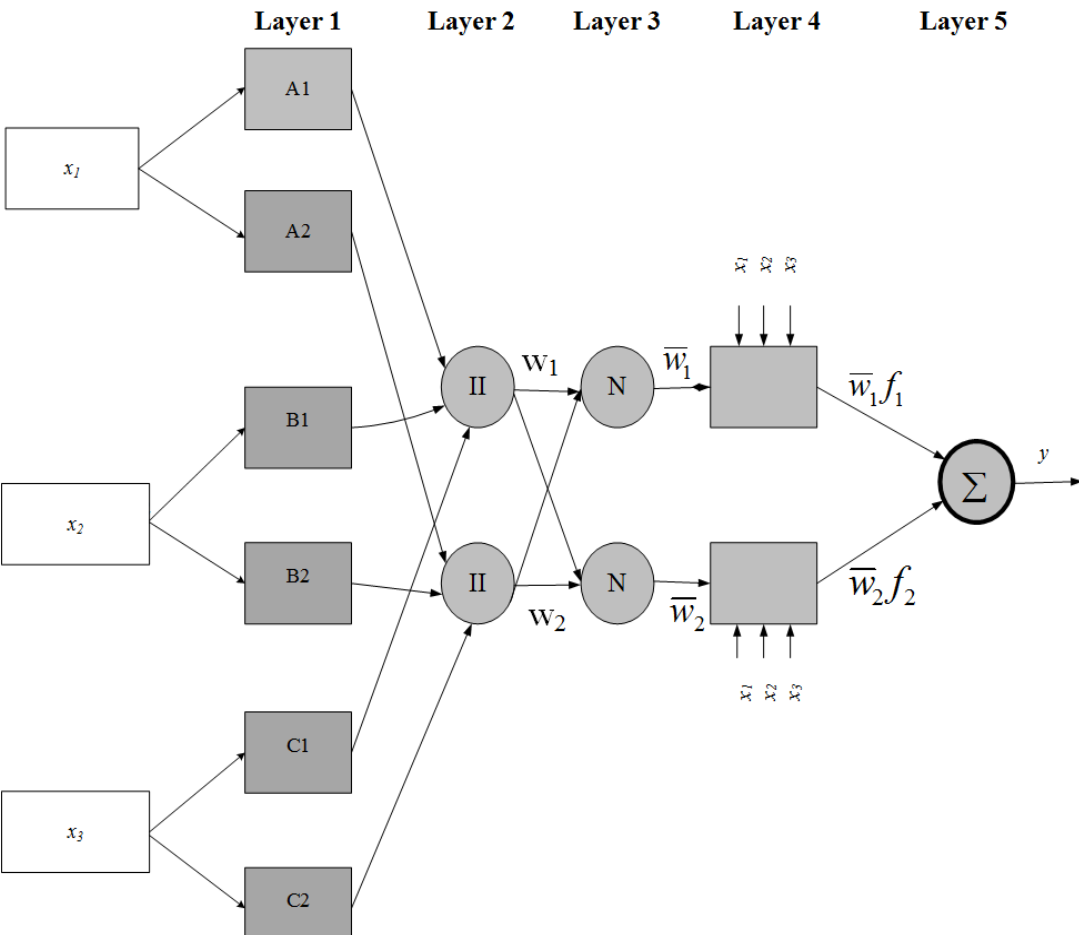
Figure 1. The neuro-fuzzy (NF) model architecture for wind speed/power prediction.